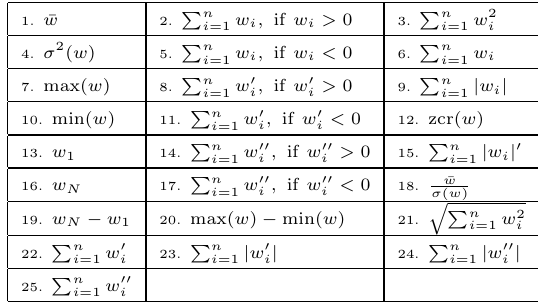
each combination of two color channels c 1 , c 2 defined as crm( c 1 , c 2 ) = med( c 1 ). c 2 Heart rate estimation was performed by counting the